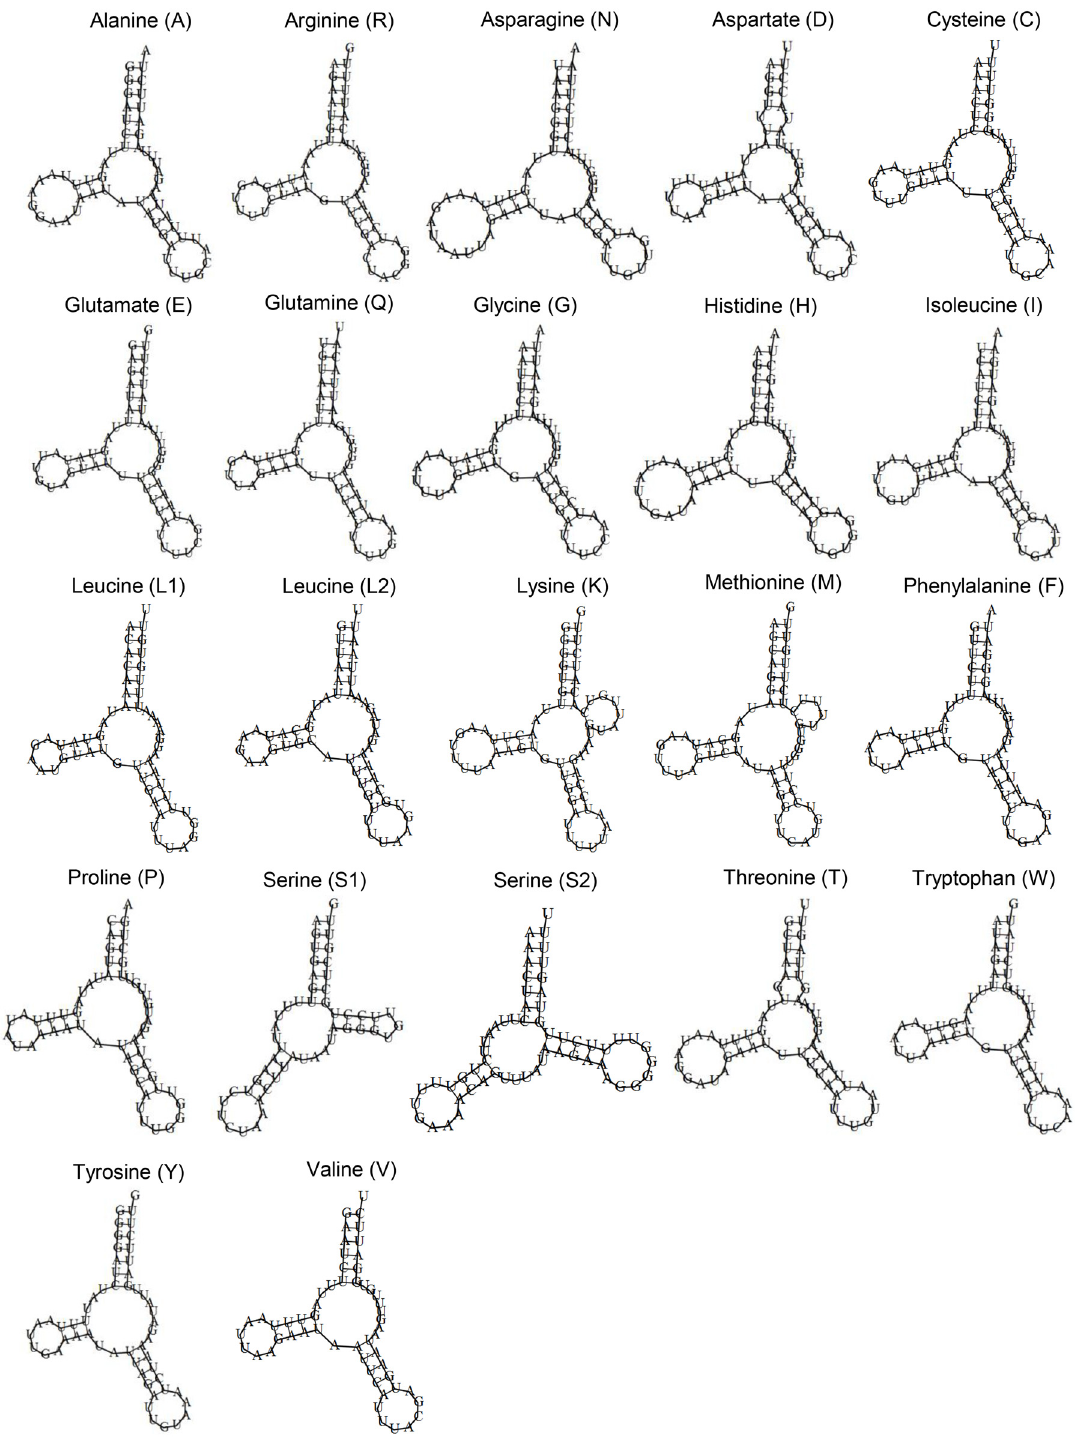
Fig 2. Cloverleaf structure of the 22 inferred tRNAs in the mitogenome of Angiostrongylus costaricensis (Costa Rica taxon). The cloverleaf structure lacked the T Ψ C-arm in 18 tRNAs except serine S1 and serine S2 and the presence of T Ψ C-loop in lysine and methionine. Serine S1 and serine S2 lacked the